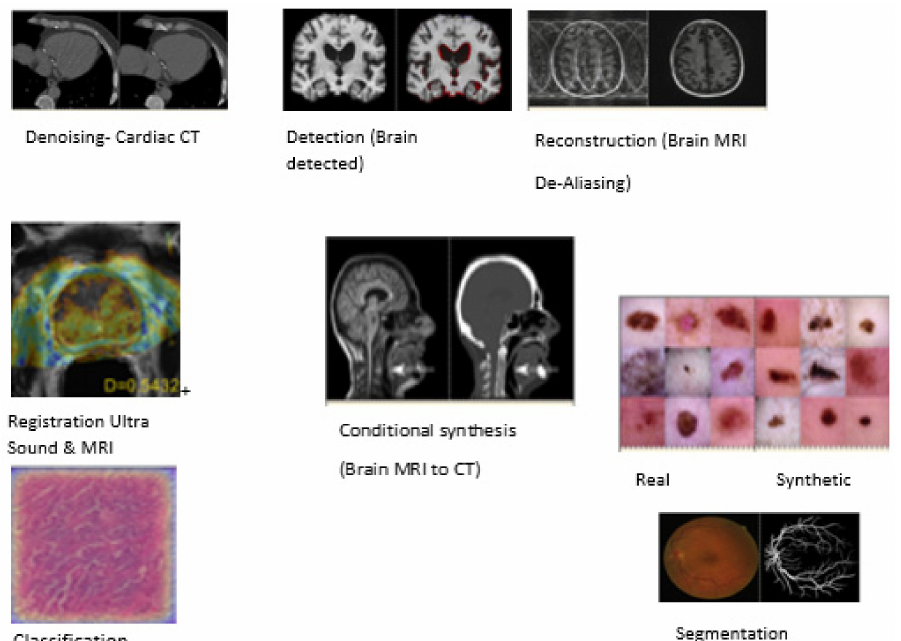
Figure 4. A survey on generative adversarial networks for medical image analysis: The pie chart represents the visual examples of GANs applications. Examples are taken from papers as follows: denoising, reprinted with permission from ref. [36]. Copyright 2017 IEEE. conditional synthesis, reprinted from ref. [49]; registration, reprinted from ref. [50], reconstruction reprinted with permission from ref. [44]. Copyright 2018 Springer. detection reprinted from ref. [51], classification reprinted from ref. [52], unconditional synthesis reprinted from ref. [17], and segmentation reprinted from ref. [53] Source: reprinted from ref.